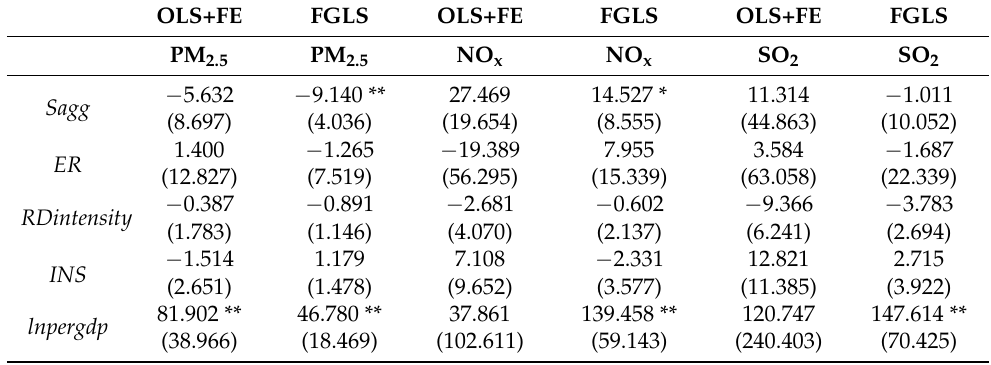
Table 4. Baseline regression of the effect of the agglomeration of producer services on air